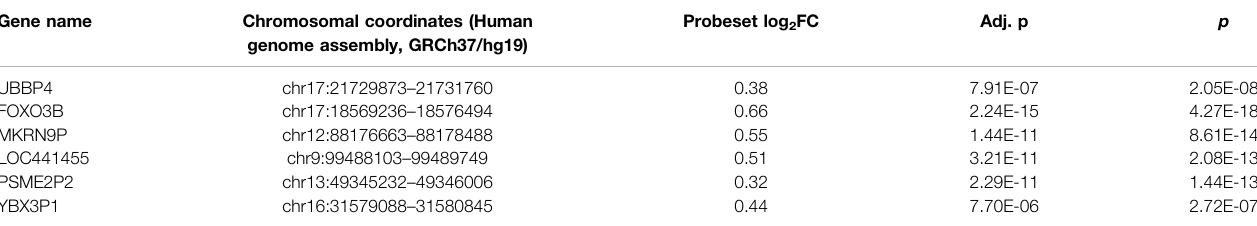
TABLE 2 | Six Differentially Expressed Pseudogenes. p -values and fold changes of TDE transcribed pseudogenes during normal pregnancy For genes with multiple Affymetrix transcript clusters, only the cluster with the lowest p -value is shown. Log2FC is the log2 ratio of the highest and lowest average expression value from 10 to 40 weeks of gestation. The sign is positive if value at 40 weeks is higher than the value at 10 weeks, and negative